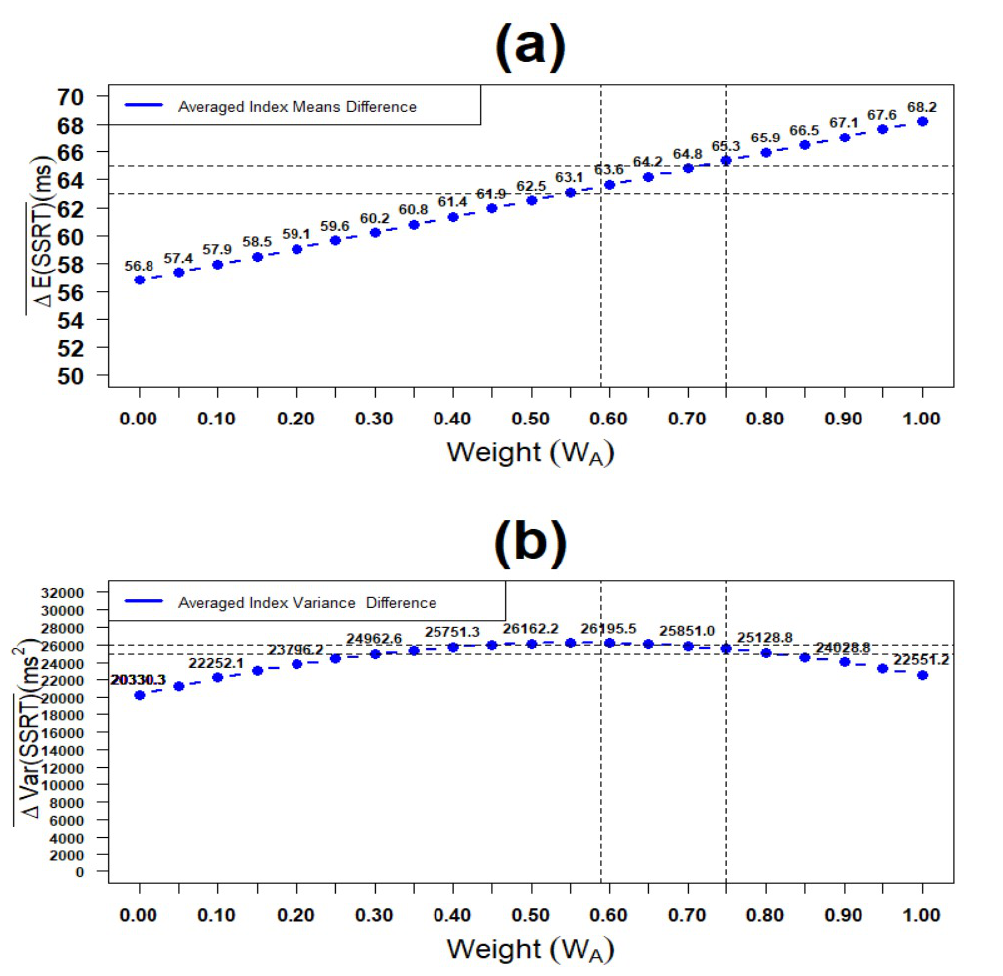
Figure 7. Plot of difference of SSRT index statistics ( SSRT Mixture vs. SSRT Single ) by weight W A ( n = 44 ) : ( a ) means and ( b )